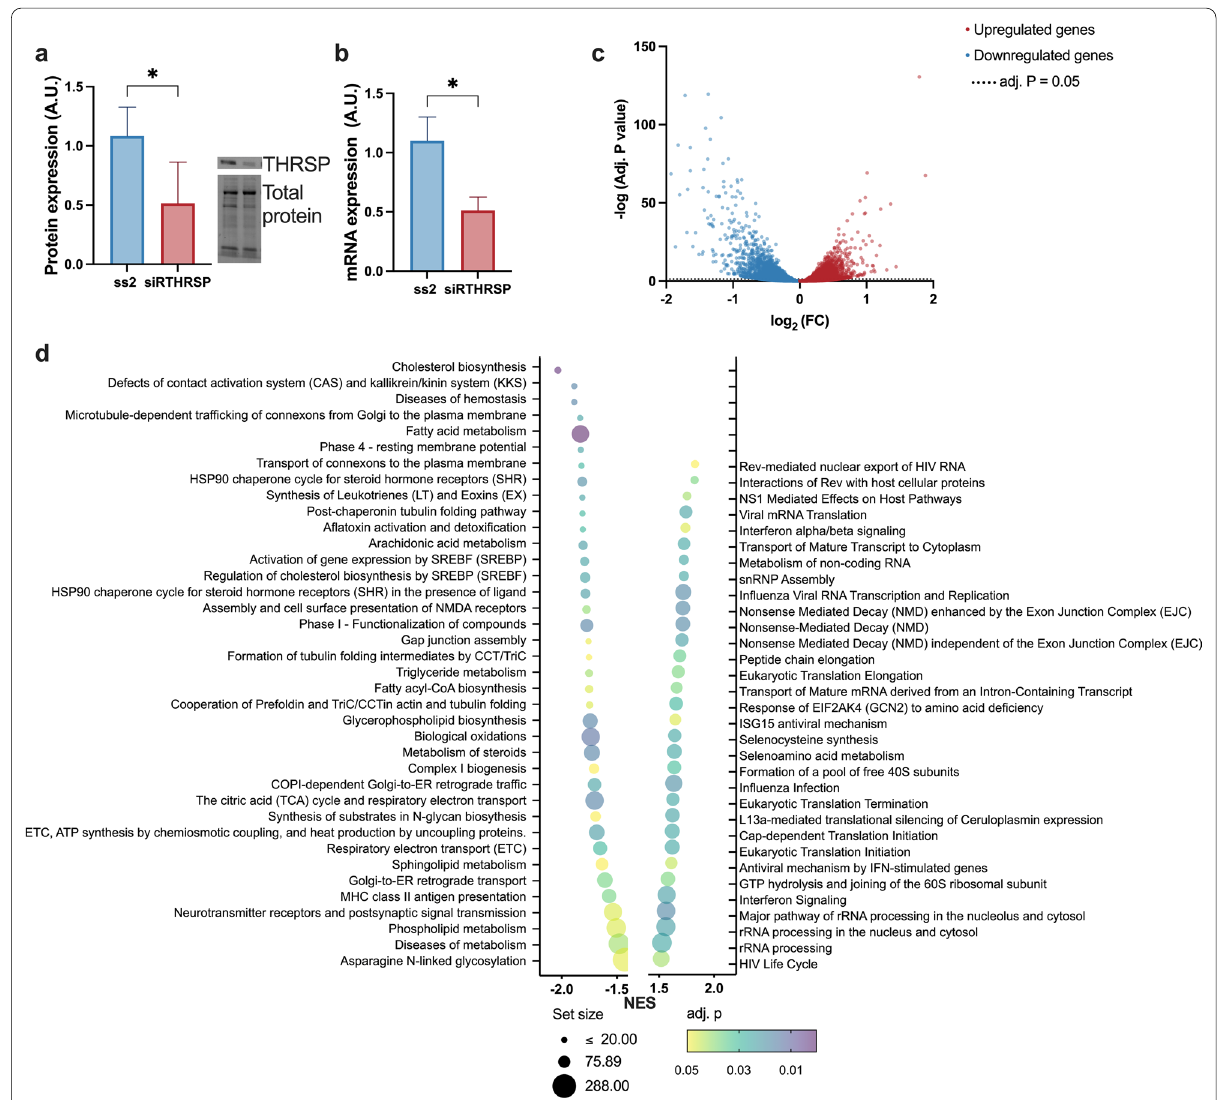
Fig. 2 THRSP silencing alters adipocyte metabolism pathways in adipocytes. a , b To study the impact of low THRSP levels on adipocyte function and gene expression, adipocytes were transfected with non‑targeting control siRNA (SS2) or THRSP siRNA (siRTHRSP; n experiments). c RNA sequencing of the transfected cells revealed significant down regulation of 2124 genes and an increase of 2049 genes’ expression upon THRSP silencing (n 4). d GSEA pathway analysis showed 38 significantly altered pathways with negative and 32 with positive = NES score. The data is represented as mean with SD. Statistical significance is designated as * P value (P adj ) 0.05 was considered as statistically ≤